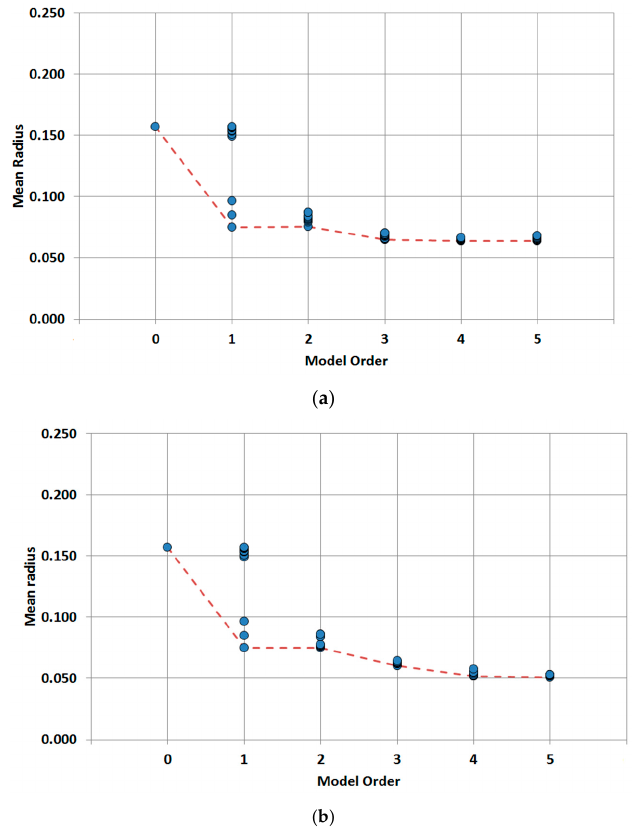
Figure 8. Distribution: Mean Radius vs. Model order. Blue dots represent values obtained for individual models and the dashed red line represents the best models: ( a ) independent variables; and ( b ) two joint variables plus additional independent variables. Table 5. Best predictive models: Distribution lines. Values in parenthesis represent the number of intervals considered in variable discretization (F stands for full